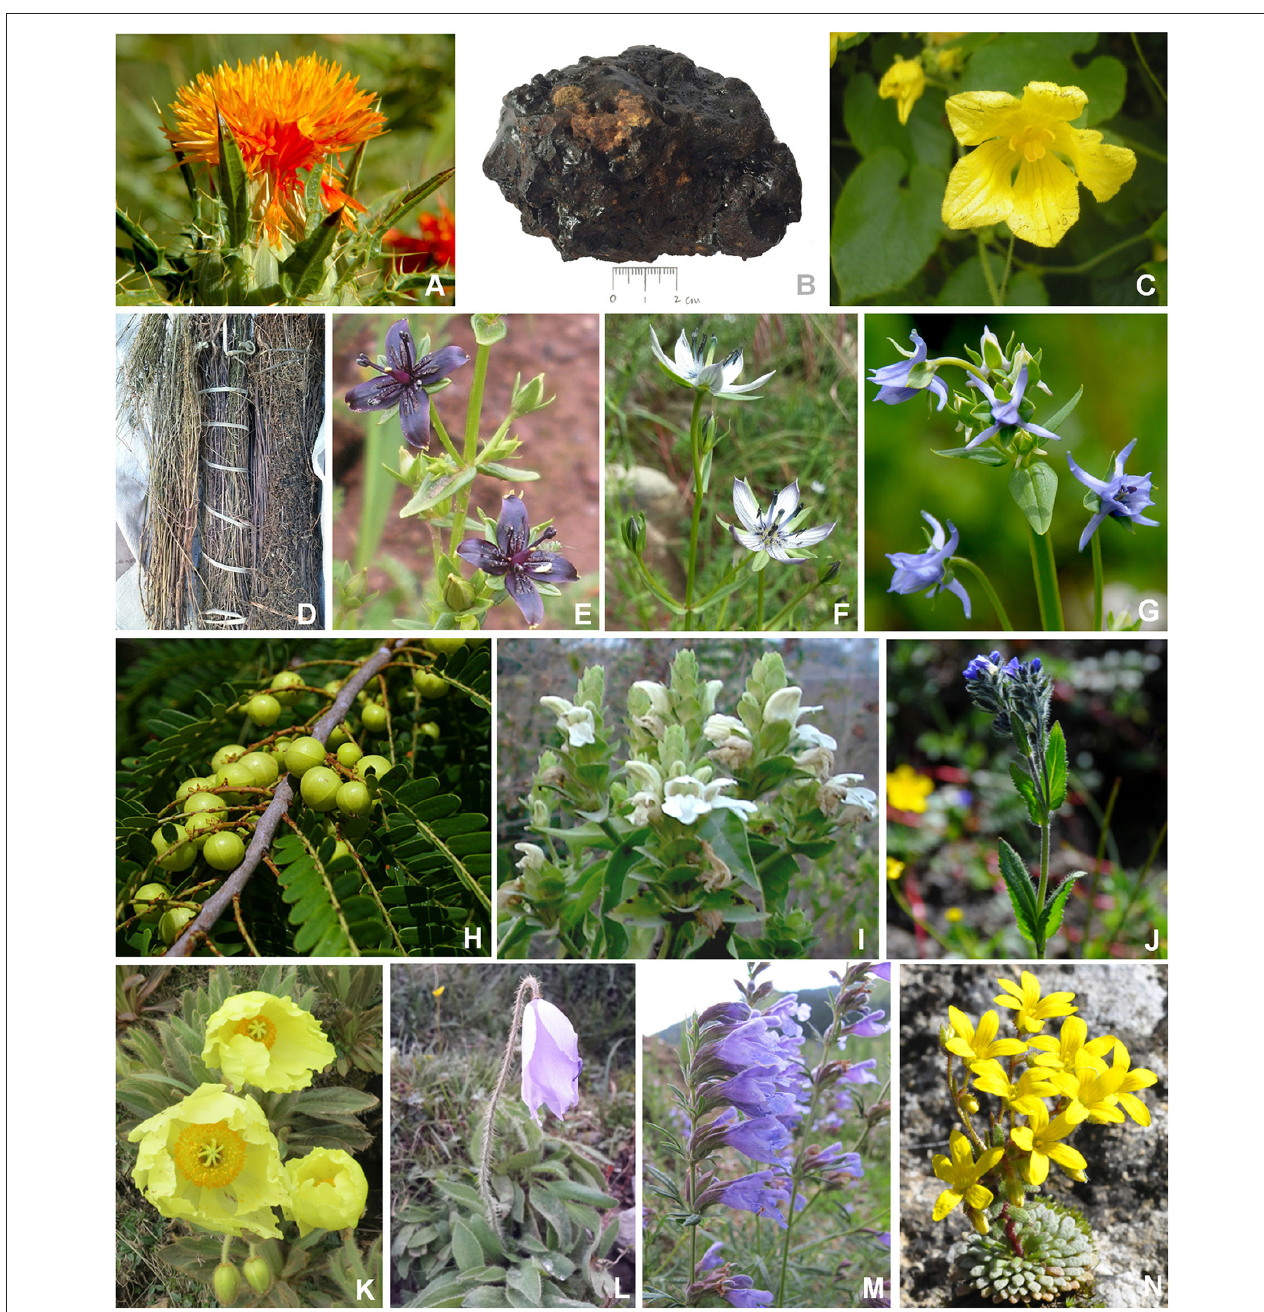
FIGURE 2 | The most frequently used natural Tibetan medicines for the treatment of liver diseases in traditional Tibetan medical system. (A) Carthamus tinctorius , (B) Brag-zhun, (C) Herpetospermum caudigerum , (D) Swertia chirayita , (E) Swertia mussotii , (F) Swertia franchetiana , (G) Halenia elliptica , (H) Phyllanthus emblica , (I) Adhatoda vasica , (J) Veronica ciliata , (K) Meconopsis integrifolia , (L) Meconopsis quintuplinervia , (M) Dracoephalum tanguticum , and (N) Saxifraga umbellulata var. pectinata